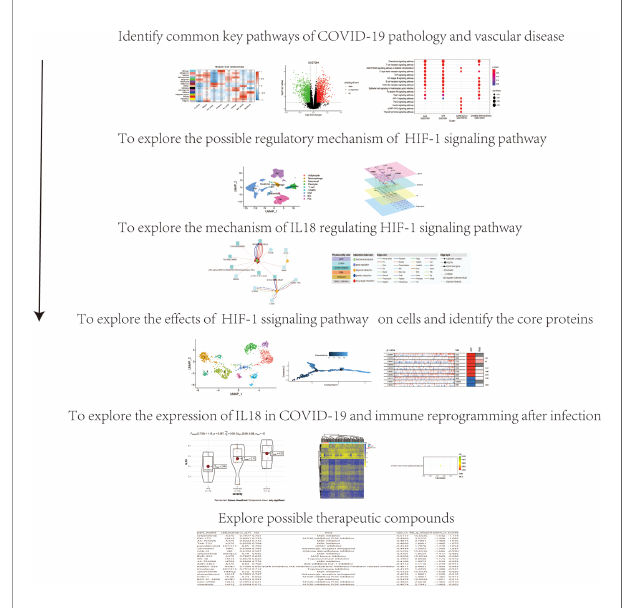
FIGURE 1 | Data processing fl ow chart of this